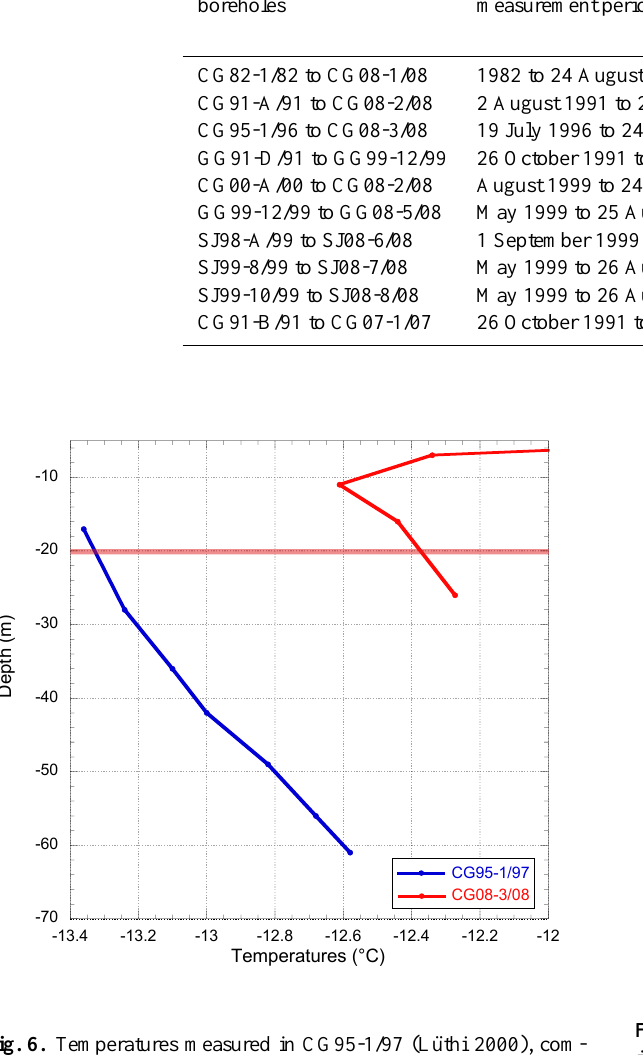
Table 3. Information about temperatures changes measured at 20m depth for some selected measurement sites. boreholes measurement period